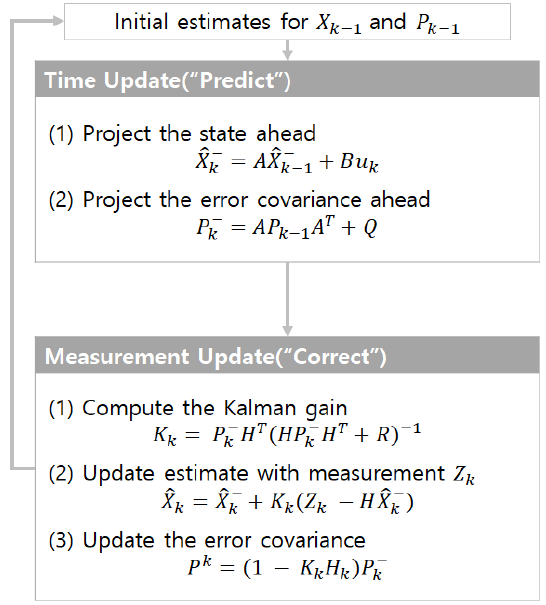
Figure 3. Kalman filter block diagram.